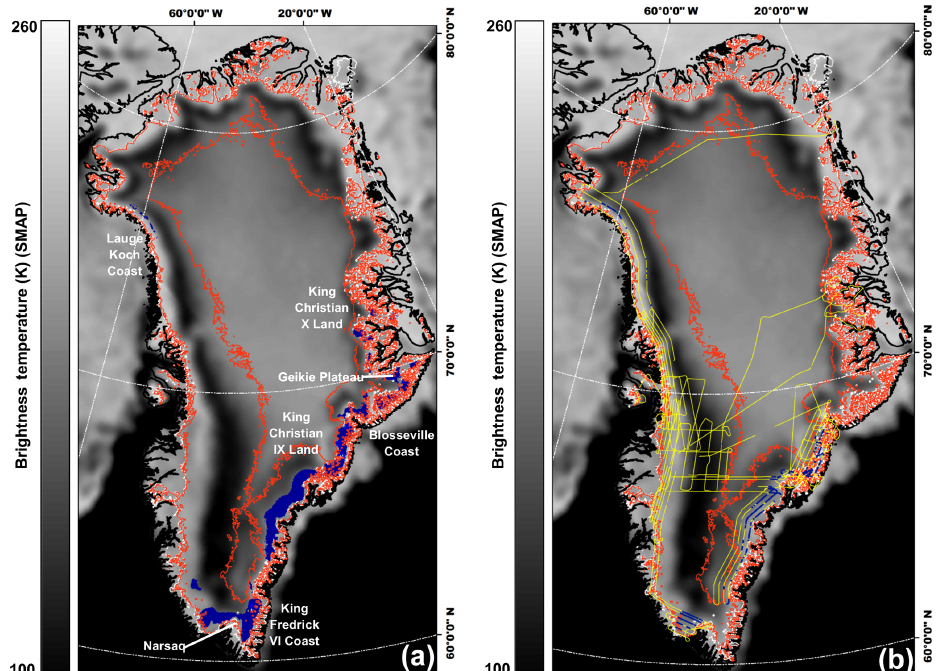
Figure 3. (a) The 2015–2016 L-band T B -derived perennial firn aquifer extent (blue shading) overlaid on an enhanced-resolution (3.125km) V-pol L-band T B image collected 15 April 2016 by the microwave radiometer on the SMAP satellite during the evening orbital pass interval over Greenland (Long et al., 2019). (b) MCoRDS-derived perennial firn aquifer locations (blue circles; Miège et al., 2016) along OIB flight lines (yellow lines), MODIS TIR T B -derived seasonal surface meltwater extent (red lines), GIMP-derived ice extent (white lines; Howat et al., 2014), and coastlines (black lines; Wessel and Smith,